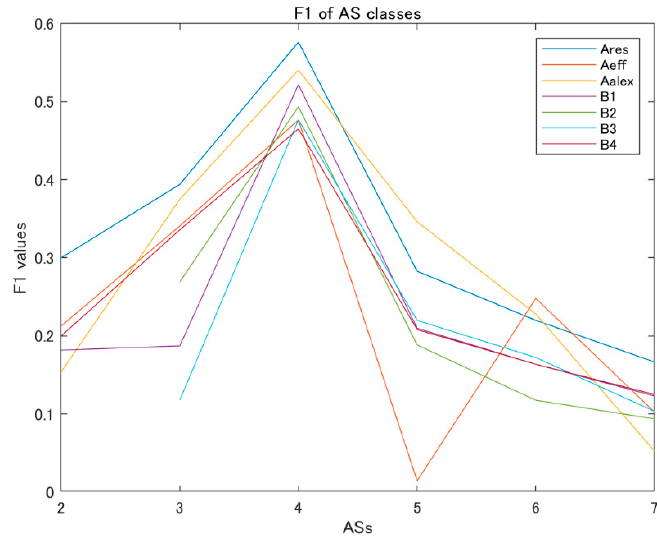
Figure 5. F1 values for various single models.